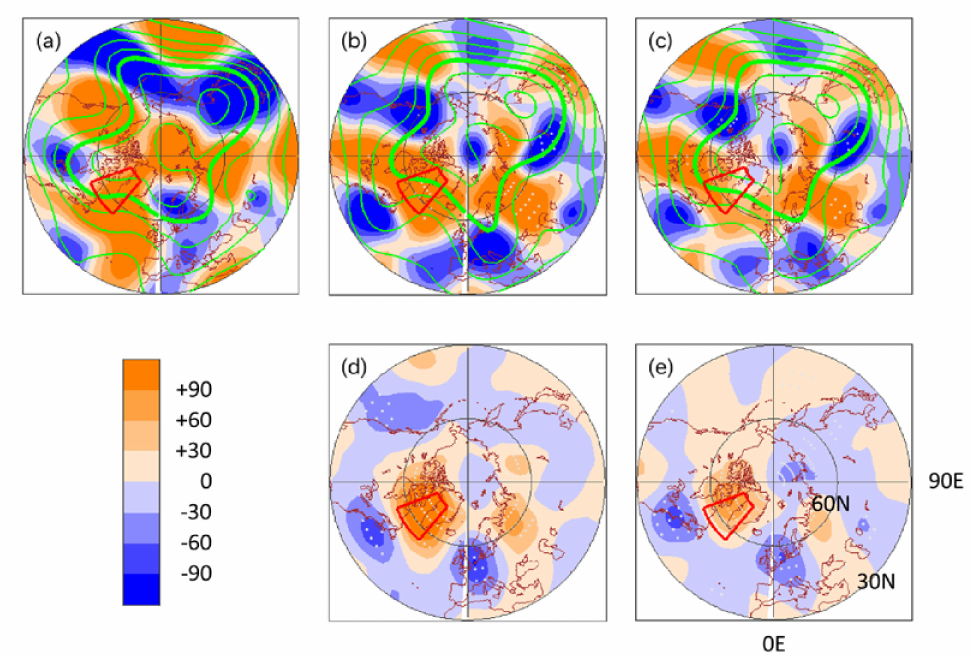
Figure 6. Same as Figure 4, for the 300 hPa geopotential height averaged from RD-6 to RD. Panel ( a ) plots the JRA-55 data, ( b ) MSSW member mean, and ( c ) non-MSSW member mean. In ( a – c ), thick green contours denote 8800 m, and contour interval is 200 m. The values generally increase with decreasing latitude. Panel ( d ) plots the di ff erence of ( b ) from ( c ). Panel ( e ) plots the regression field onto the heat flux. The region used for Figure 5d–f is highlighted in red.